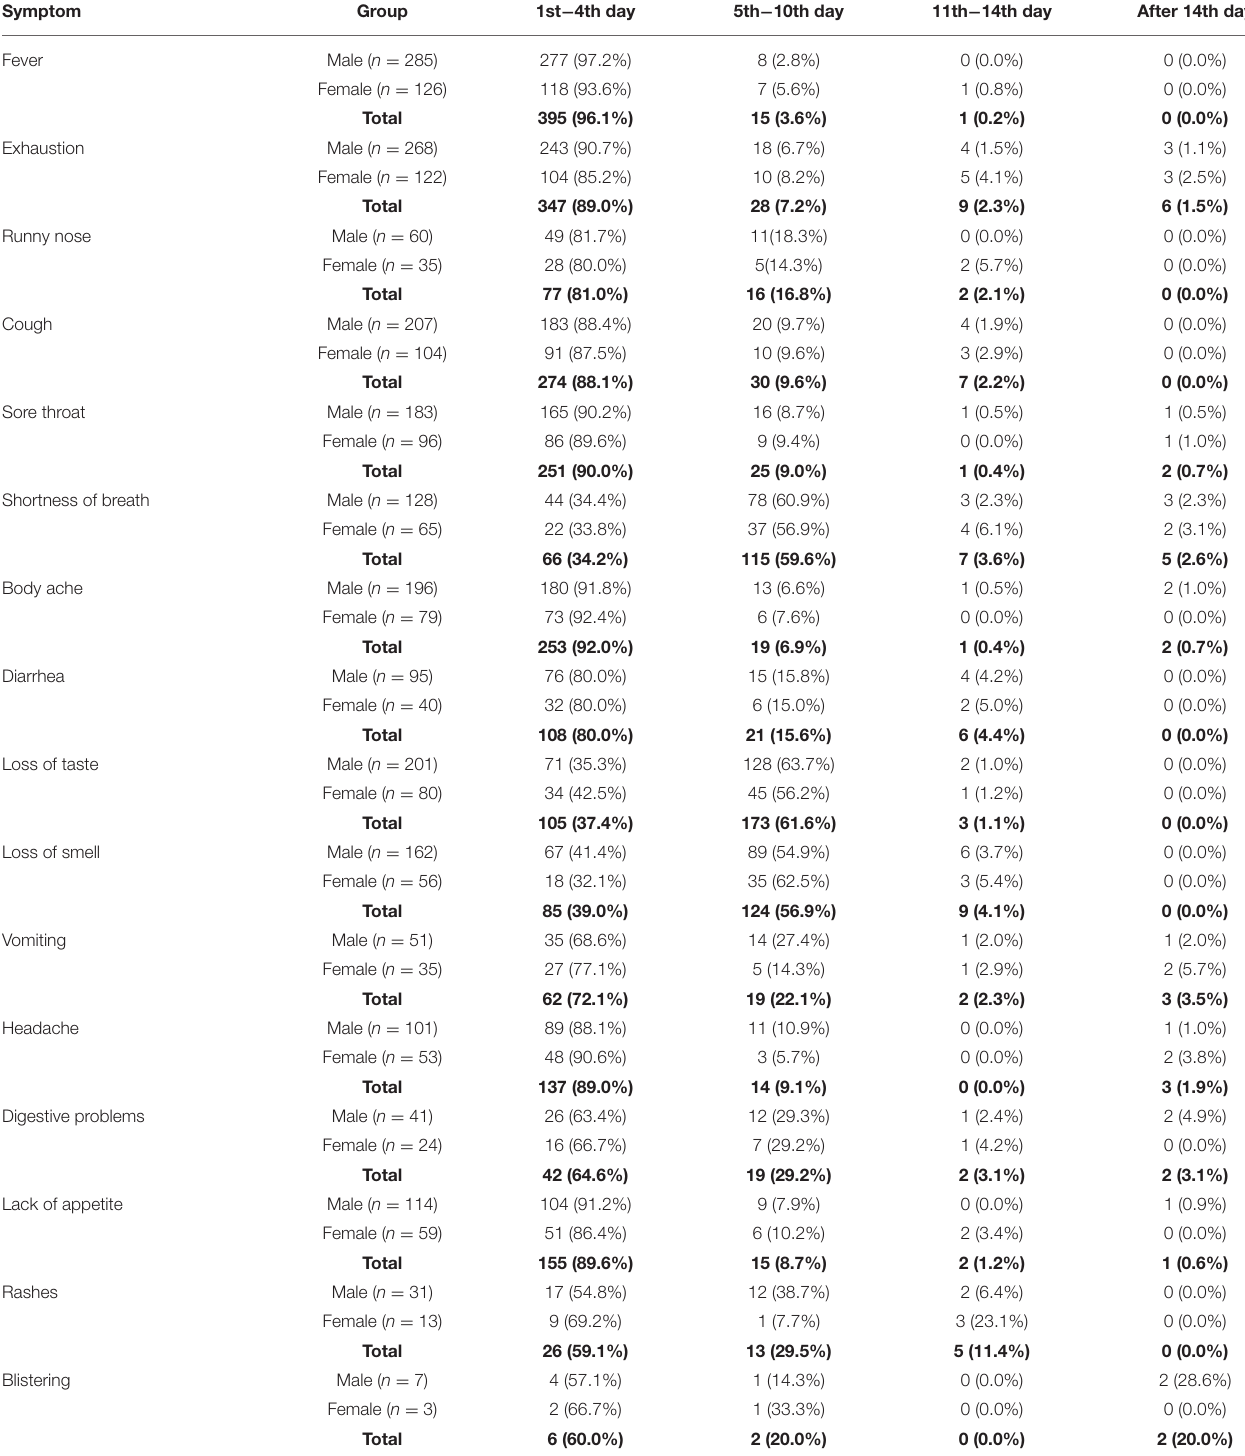
TABLE 5 | Onset of COVID-19-associated symptoms in the patients, Bangladesh, 2020. Symptom